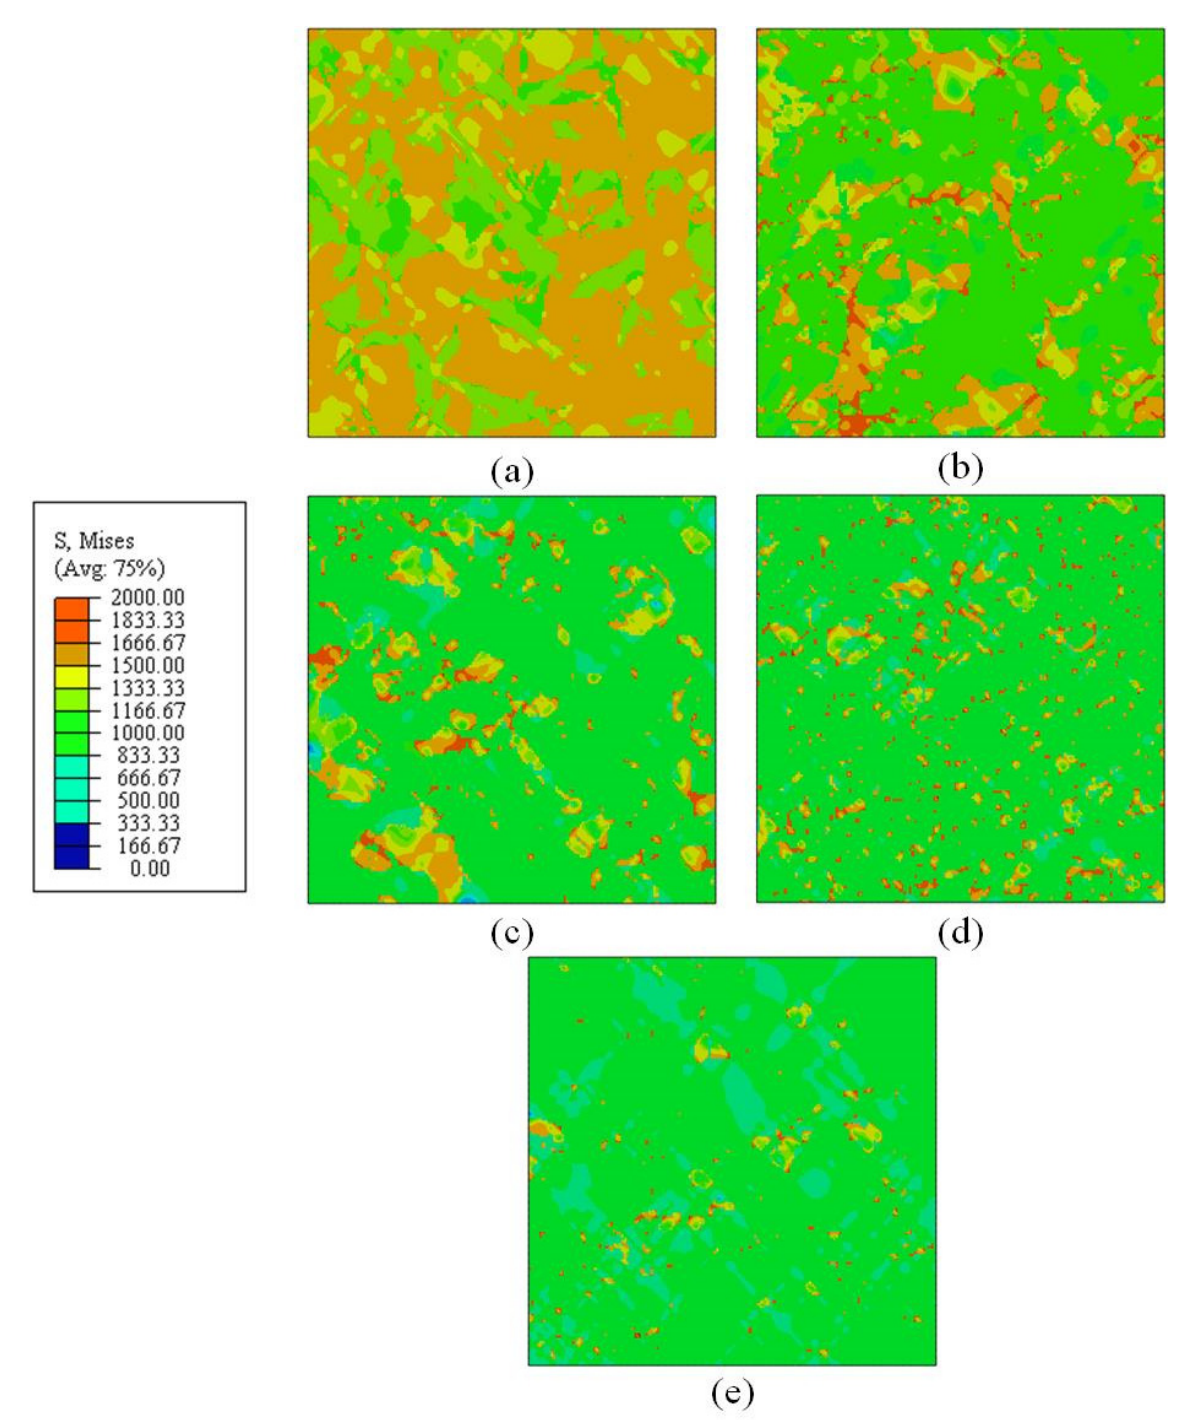
Figure 12. Predicted local distributions of von Mises equivalent stress at the overall strain of 7% for RVEs with varying B/M phase volume fractions ( a ) 30%B + 70%M; ( b ) 68%B + 32%M; ( c ) 80%B + 20%M; ( d ) 90%B + 10%M; ( e ) 96%B + 4%M (Units: Pa).